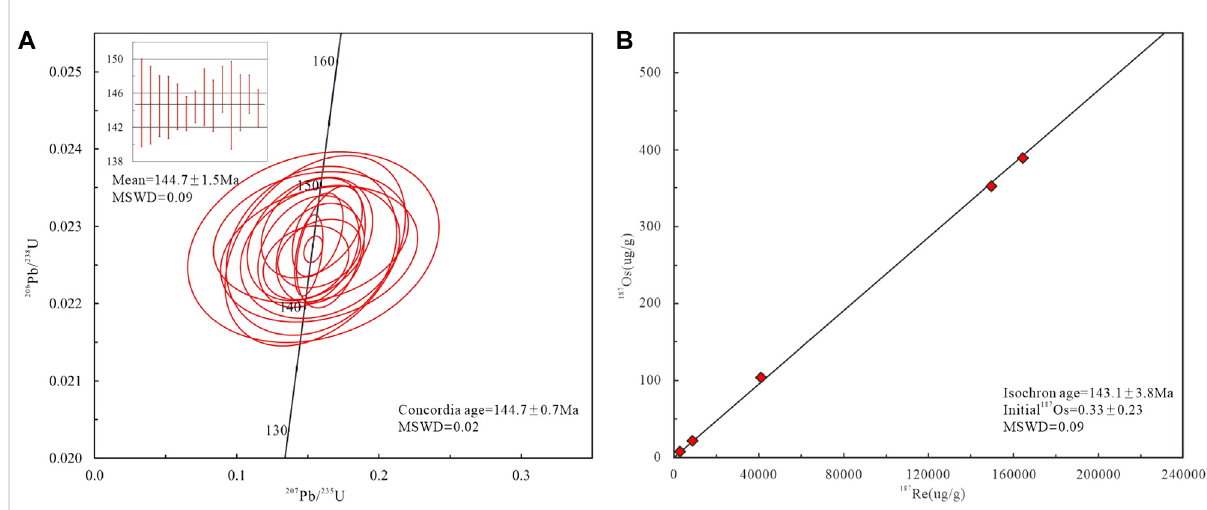
age of 143.1 ± 3.8 Ma, with MSWD = 0.094 and an initial 187 Os of 0.33± 0.23